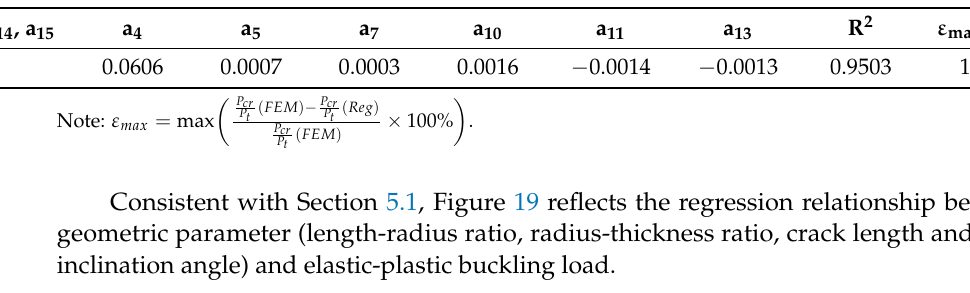
Table 6. Regression coefficients for cracked cylindrical shell with simple